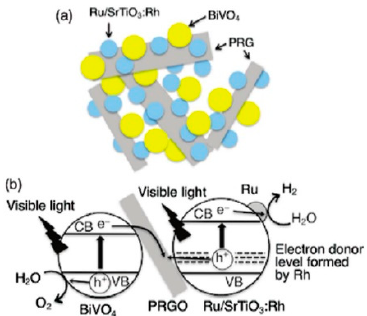
Figure 10. ( a ) Schematic display of a suspension of Ru/SrTiO 3 and partially reduced GO (PRGO)/BiVO 4 in water. ( b ) Mechanism of water splitting using Z-scheme system consisting of Ru/SrTiO 3 and PRGO/BiVO 4 under irradiation. Reproduced with permission from Reference [99]; copyright (2018), American Chemical Society.